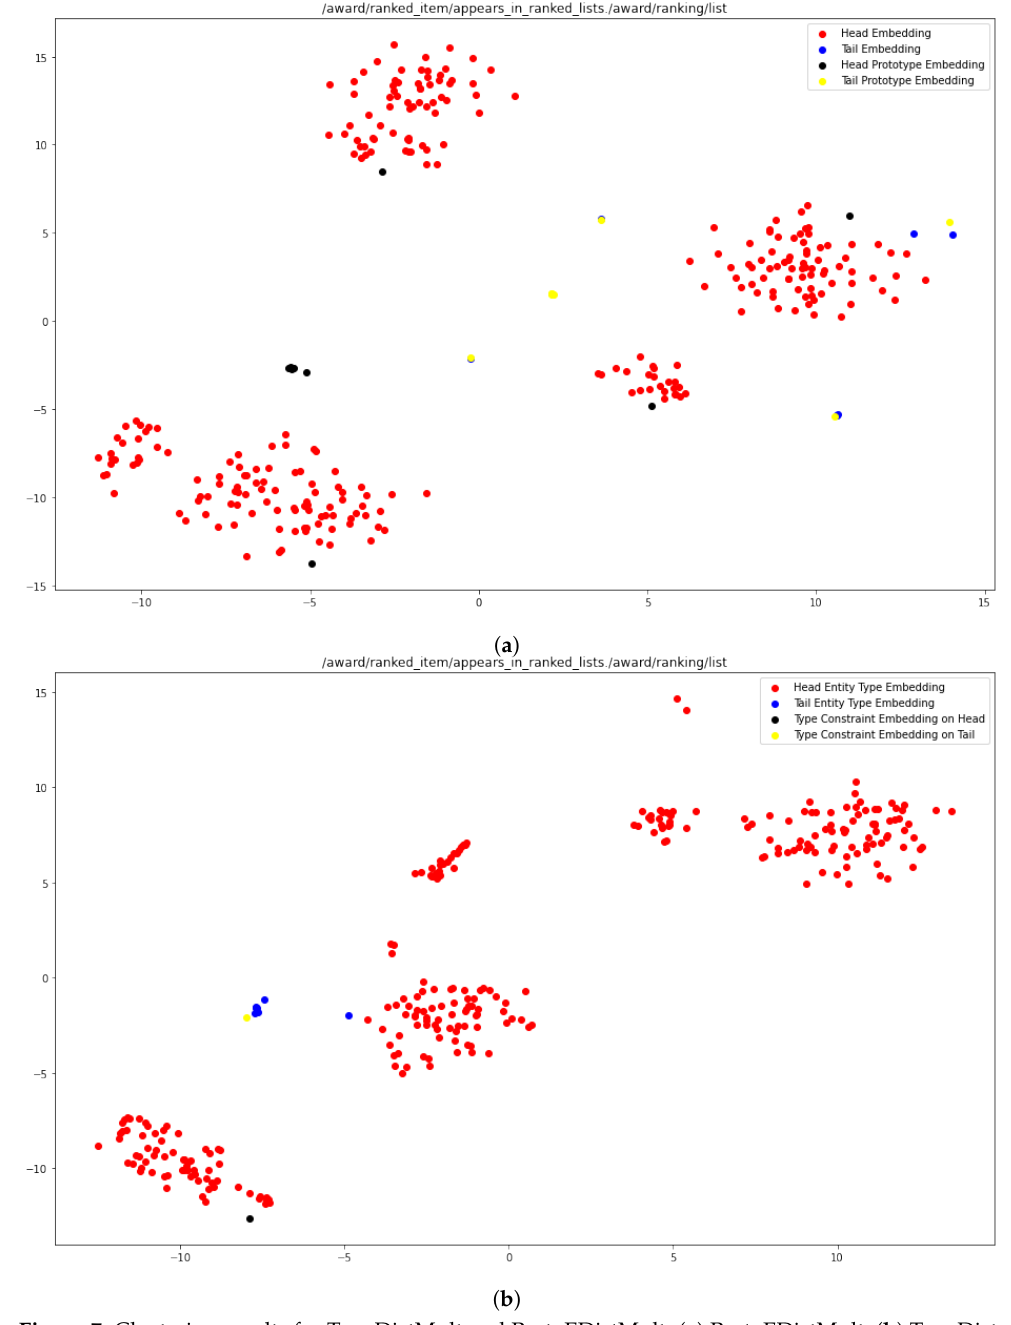
Figure 7. Clustering results for TypeDistMult and ProtoEDistMult. ( a ) ProtoEDistMult; ( b ) TypeDist-